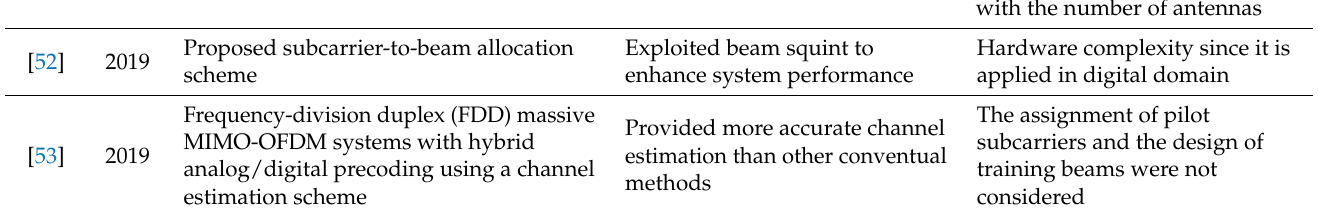
Table 2. Comparison among various studies conducted in the field of beam squint from 2012 to 2022.